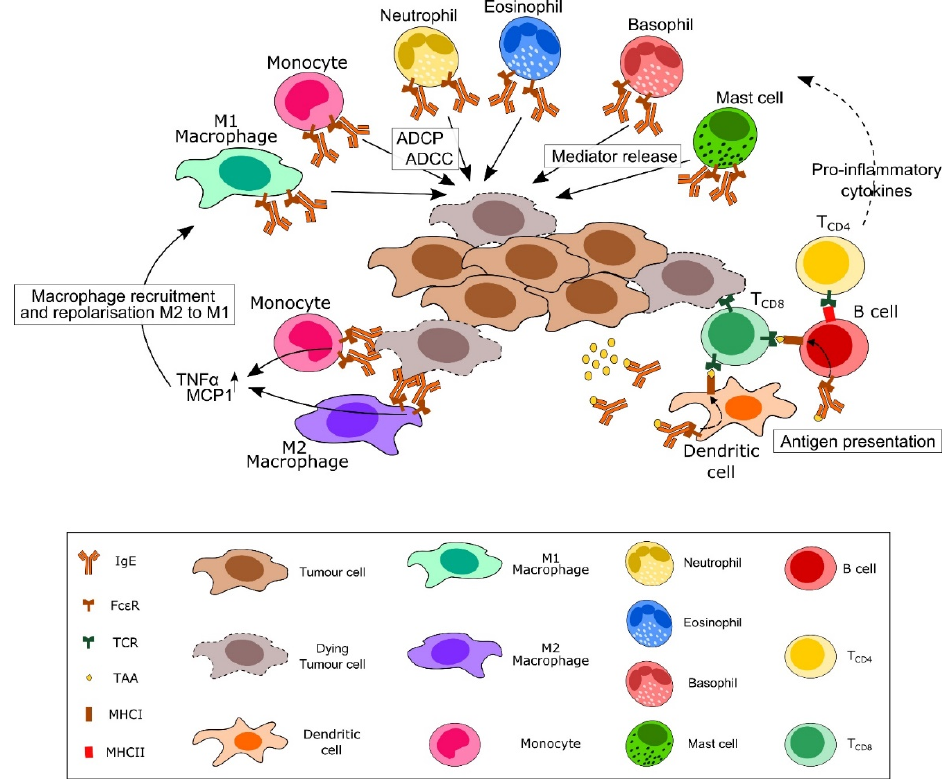
Figure 1. IgE and IgE therapy-mediated cellular immune surveillance against cancer. Direct and cell-mediated effects of IgE against tumour cells (shown in brown). IgE is able to engage with a unique repertoire of effector cells via the IgE receptors Fc ε receptor I (Fc ε RI) and CD23/Fc ε RII. These interactions can drive potentially anti-tumour functions, including antibody-dependent cell-mediated cytotoxicity (ADCC) or phagocytosis (ADCP) and release of cytotoxic mediators. IgE engagement with monocytes and alternatively activated M2 macrophages can drive repolarisation to a M1-like classically activated phenotype, as well as increased macrophage recruitment to tumour sites. IgE can also contribute to antigen presentation via dendritic cells and B cells and activate both CD4 and CD8 T cells, further promoting a pro-inflammatory environment and tumour cytotoxicity.